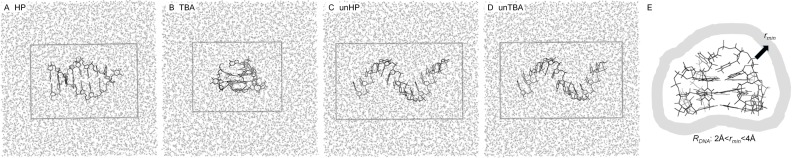
Whole MD systems and grid inhomogeneous solvation theory (GIST) analysis regions for (A) HP, (B) TBA, (C) unHP and (D) unTBA, and (E) the definition of GIST analysis RDNA used in this study. DNA strands are shown in black stick models, and oxygen atoms of water molecules are shown as gray dots. Rectangular boxes in panels A, B, C and D represent the GIST analysis regions for each system. In panel 2E, rmin is the minimum distance between DNA atom and the center of voxel, and RDNA (colored in gray around DNA) is the GIST analysis region in this study.